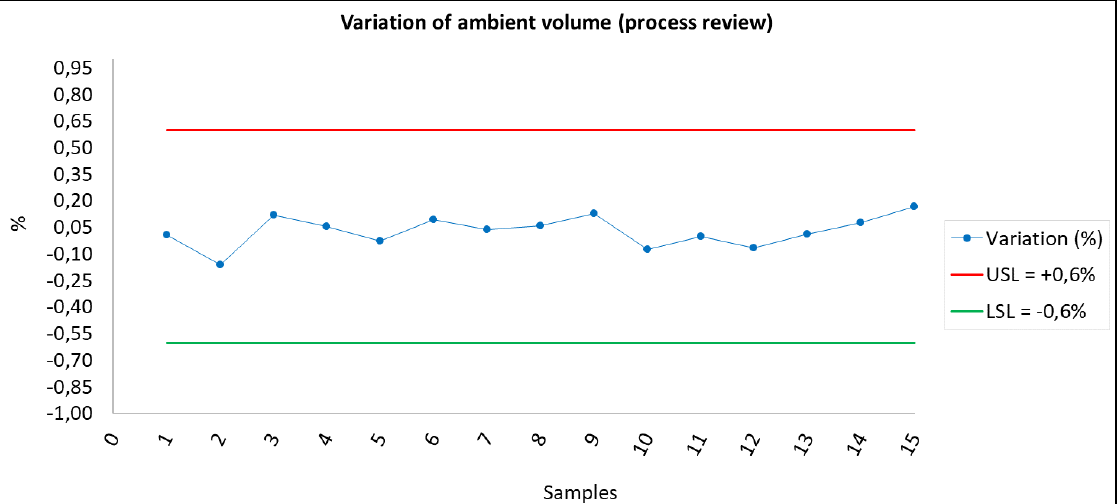
Figure 8: Graph of values and specification limits for Ambient Volume - process